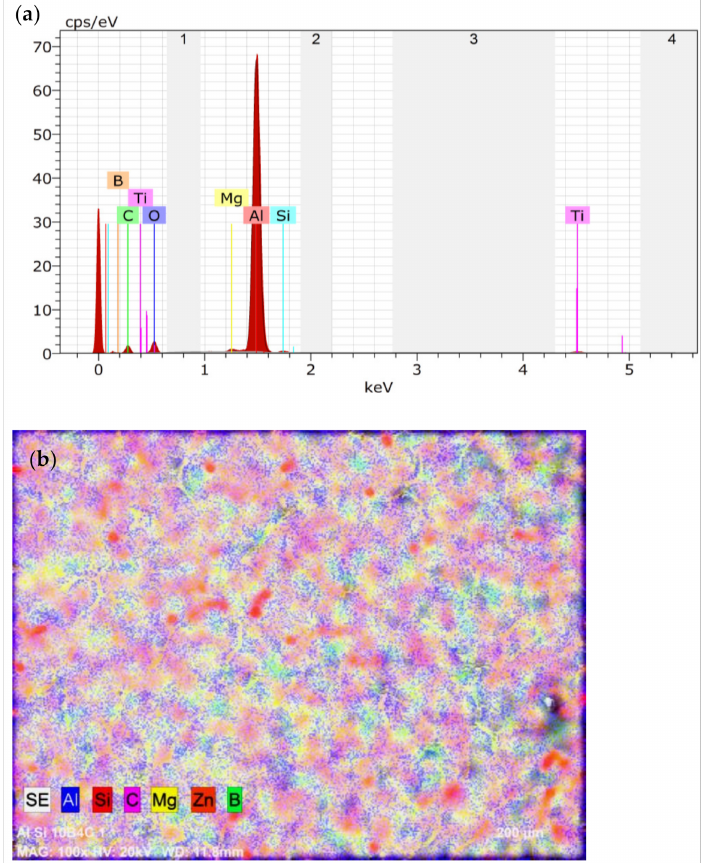
Figure 3. Analysis provided for the fabricated composite: ( a ) EDAX and ( b ) elemental